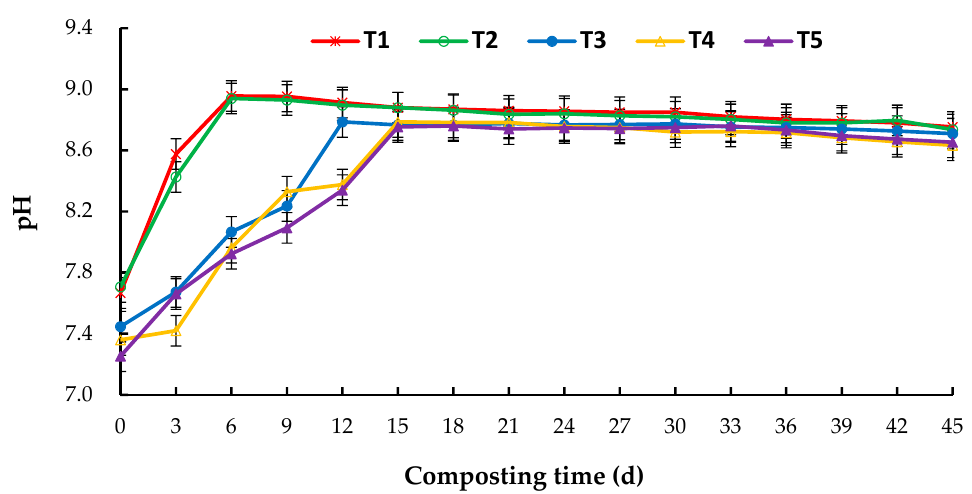
Figure 2. Changes in pH during composting of corn straw and cow dung under different C/N ratios.